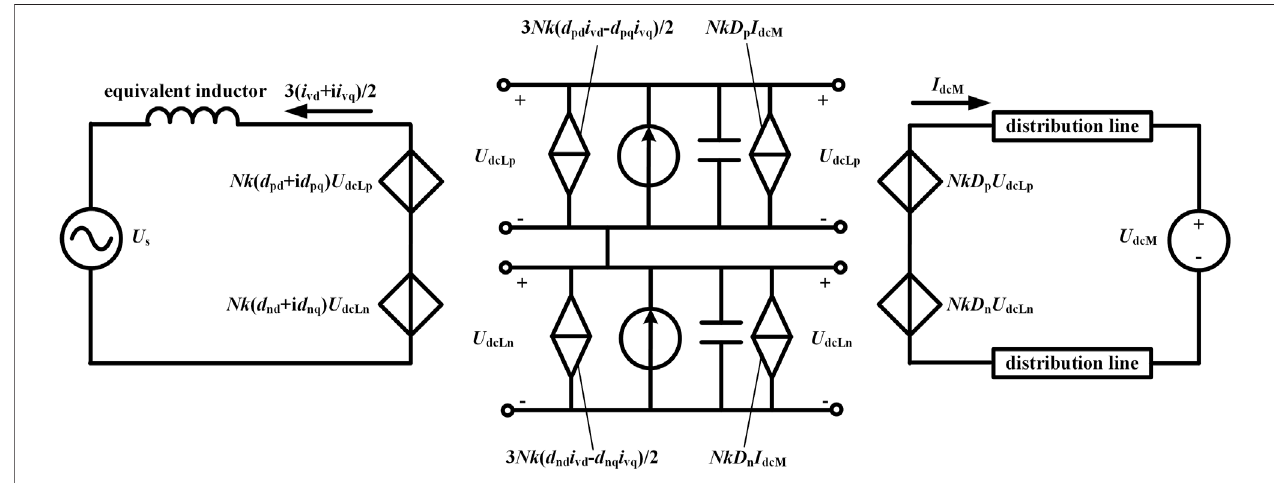
FIGURE 5 | Equivalent circuit of LVDC bipolar power fl ows.